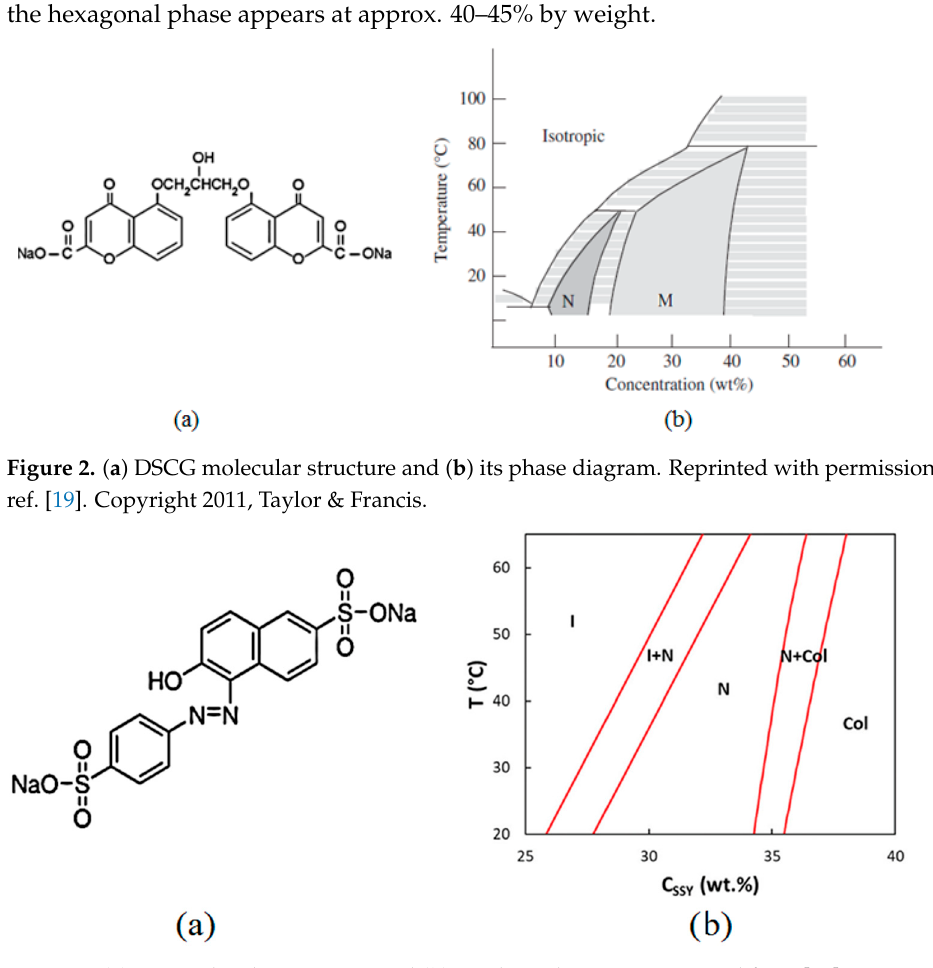
Figure 3. ( a ) SSY molecular structure and ( b ) its phase diagram. Reprinted from